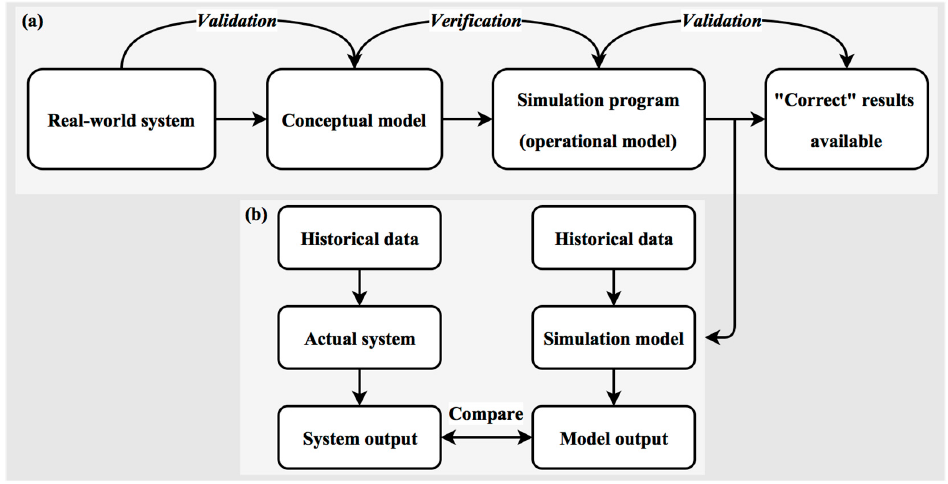
Figure 3. The applied approach for validation process (Reproduced after [10]).